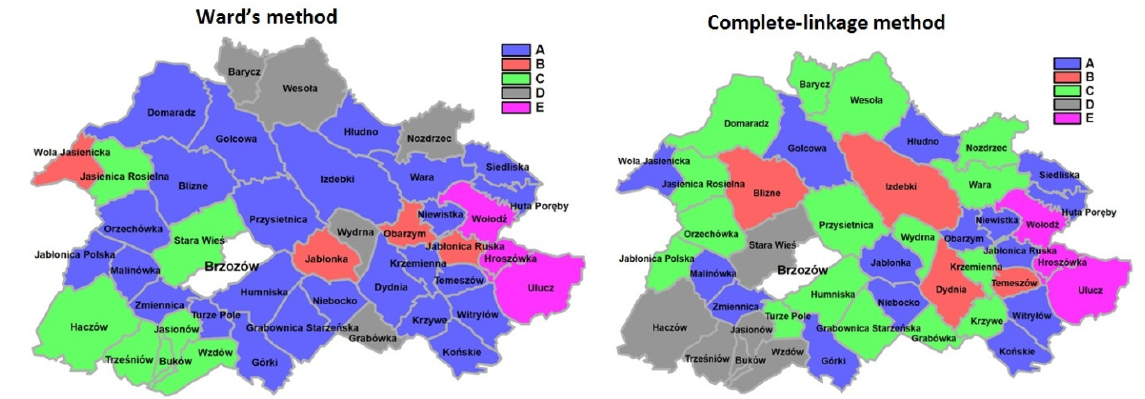
Figure 4. Division of the study area by means of the methods used.